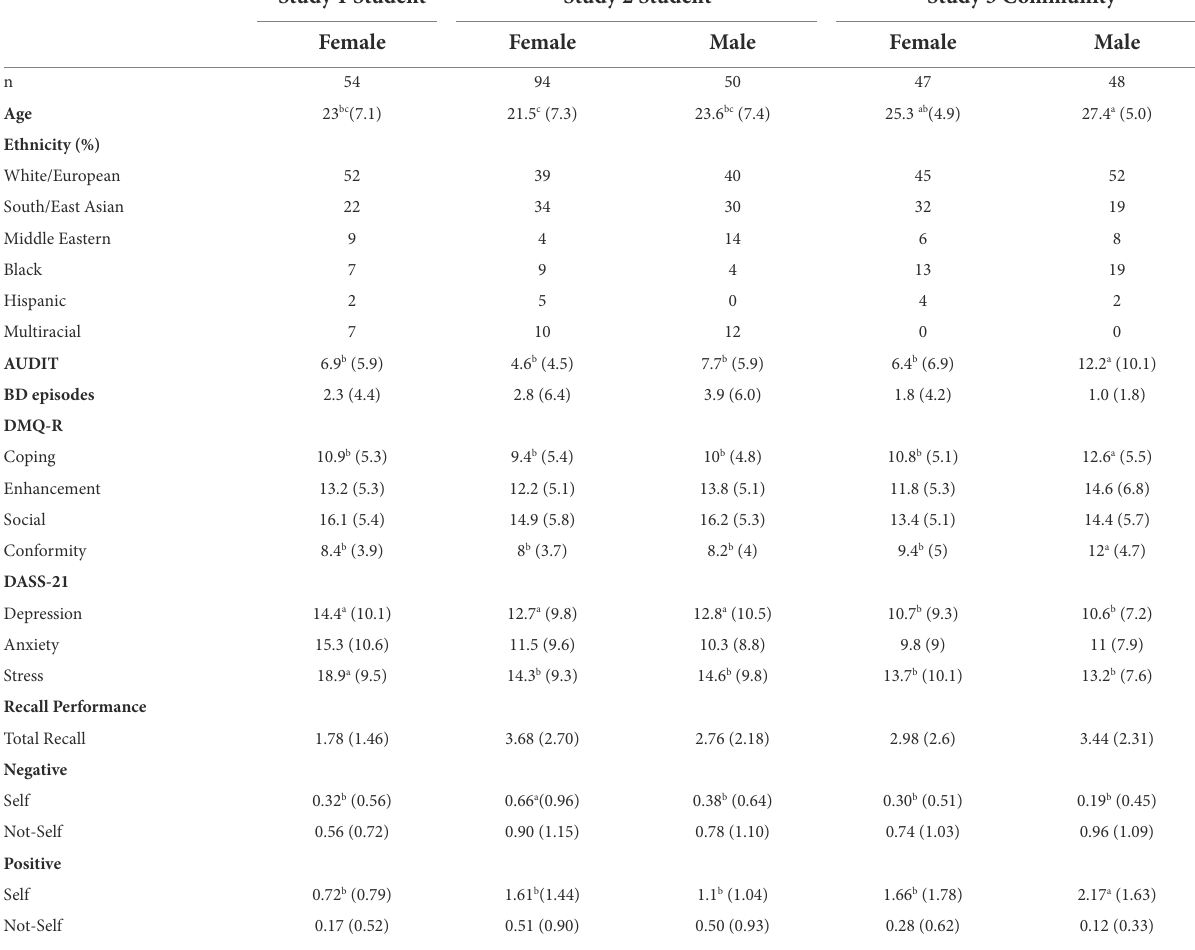
TABLE 1 Sample characteristics across the three